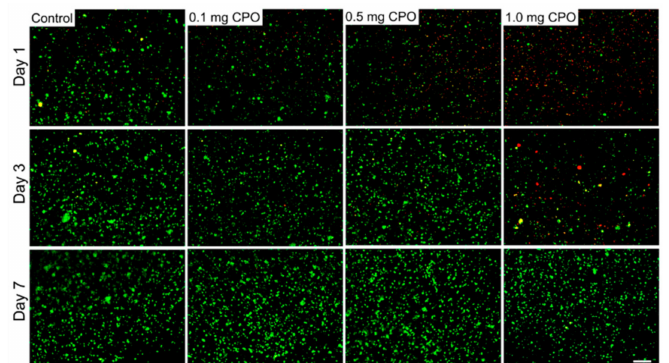
Figure 9. Live / Dead cell staining of C2C12 in GelMA bioinks with di ff erent CPO concentrations (0.1, 0.5, and 1.0 mg / mL) crosslinked with UV light. Images were taken on days 1, 3 and 7. Green color represents healthy cells and red color represents dead cells. Scale bar denotes 200 µ